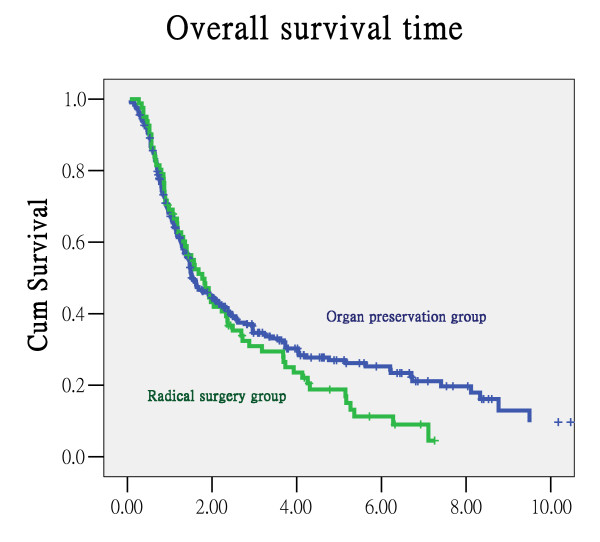
Overall survival curve.